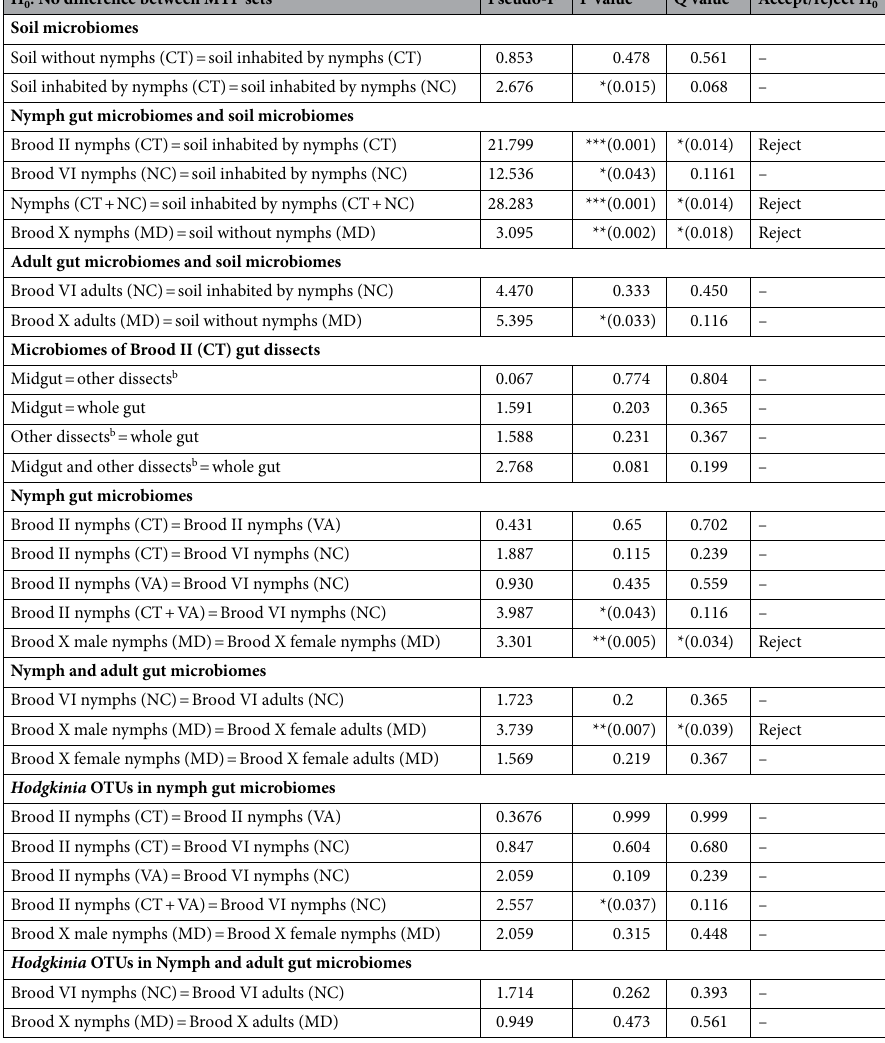
Table 1. Beta diversity set-significance analysis. Permutational multivariate analysis of variance (PERMANOVA) results are shown between MTP sets employing Bray–Curtis Beta diversity distance measure and corrected for multiple comparisons following read and gene copy number normalization. a Q value, False Discovery Rate (FDR) adjusted P value; b other dissects include filter chamber (n = 1), Malpighian tubules and hindgut (n = 2), and rectum (n = 1); (*) P ≤ 0.05, (**) P ≤ 0.01, (***) P ≤ 0.001; (–) accept H 0